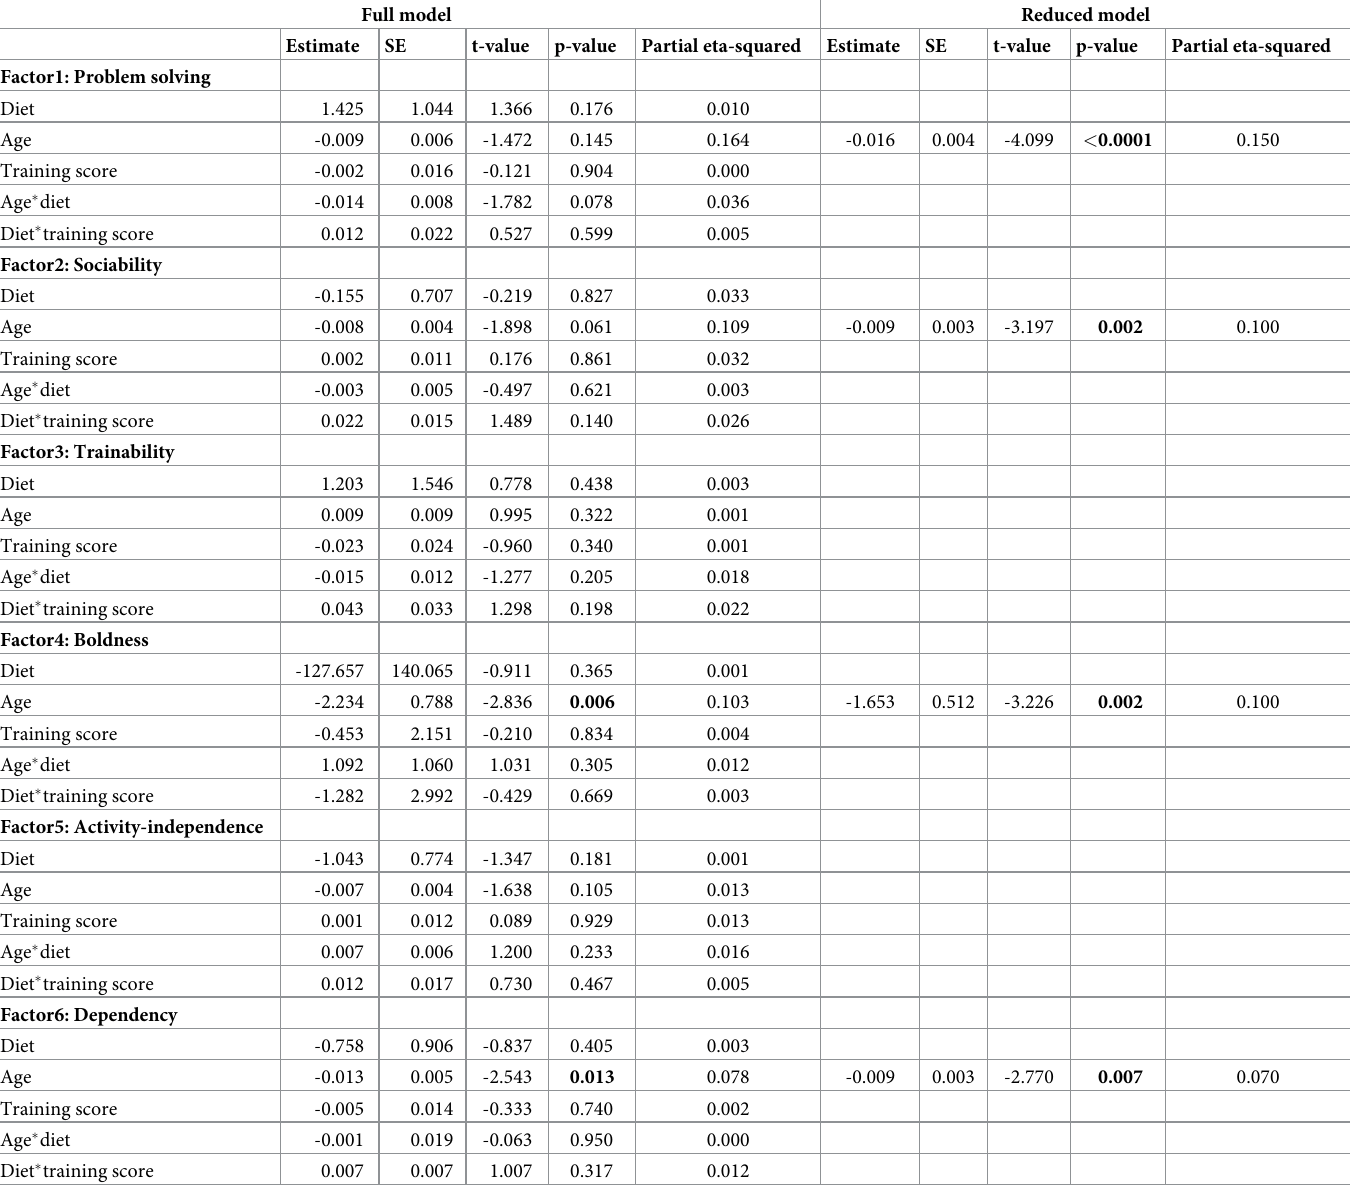
Table 14. Results of the full and reduced linear models on the six factors generated from the